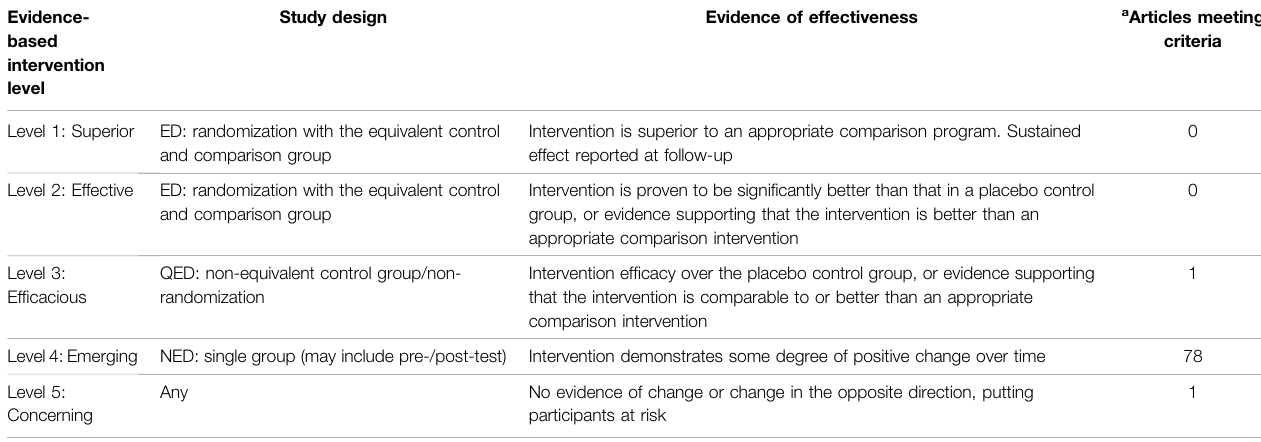
TABLE1| LevelsofEvidence-BasedInterventionEffectivenessscale(LEBIE).TheLEBIEscaletakenfromJackson(2009)andusedbyGershenfeld(2014).ED,Experimental design; QED, Quasi-experimental design; NED, Non-experimental design. Evidence- based intervention